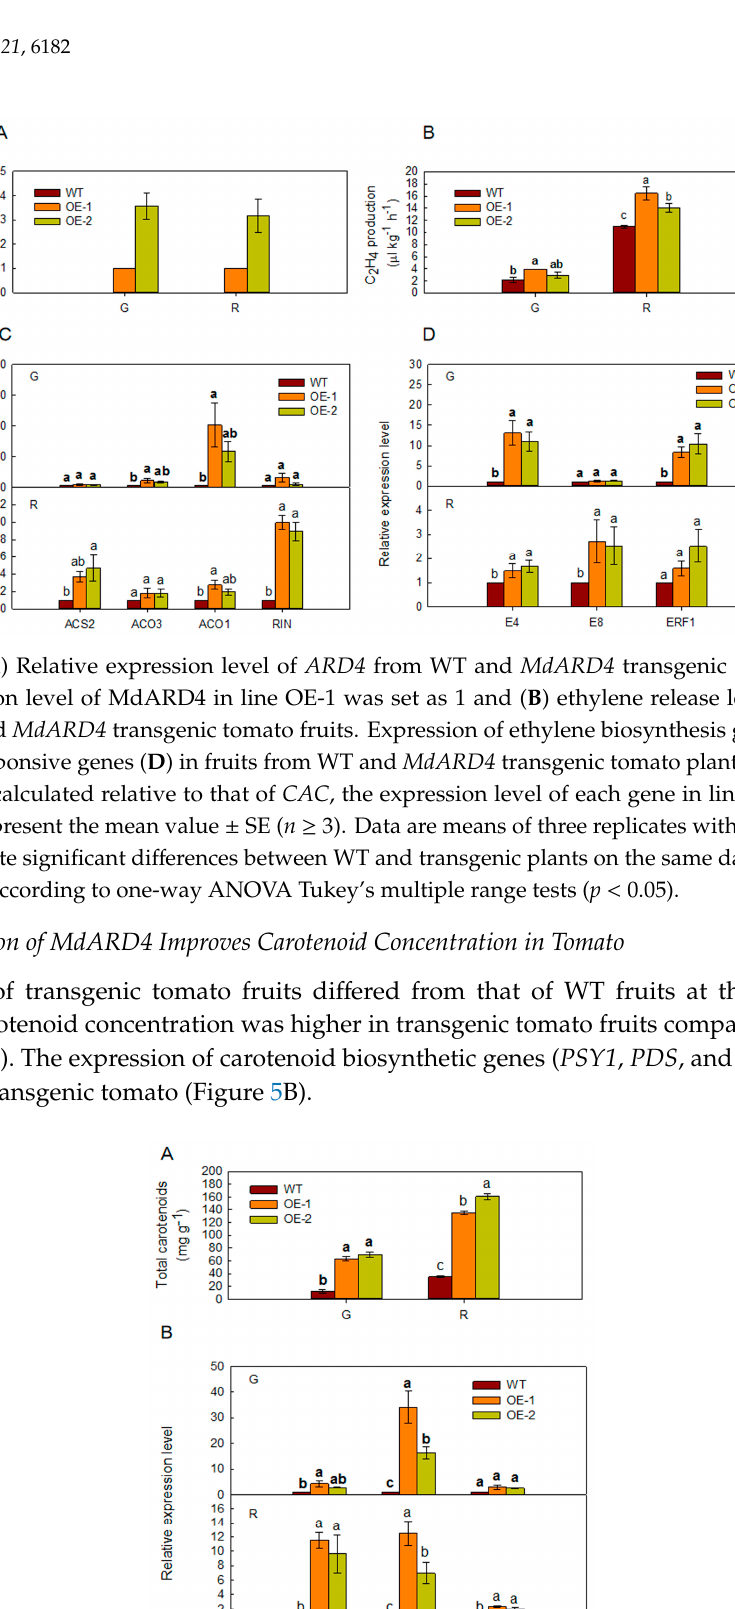
Figure 5. ( A ) The carotenoid concentrations in fruits from WT and MdARD4 transgenic tomato plants and ( B ) expression of carotenoid biosynthesis genes in fruits from WT and MdARD4 transgenic tomato plants, the expression level of each gene in line WT was set as 1. Data are means of three replicates with SD. Different letters indicate significant differences between WT and transgenic plants on the same day of different treatments, according to one-way ANOVA Tukey’s multiple range tests ( p < 0.05).